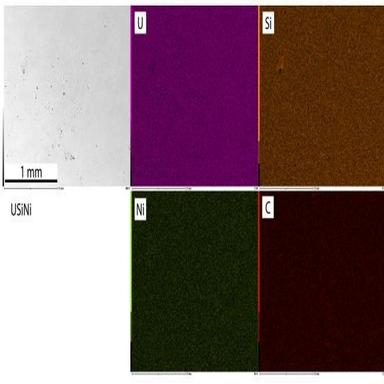
SEM-EDS images of USiNi after annealing.